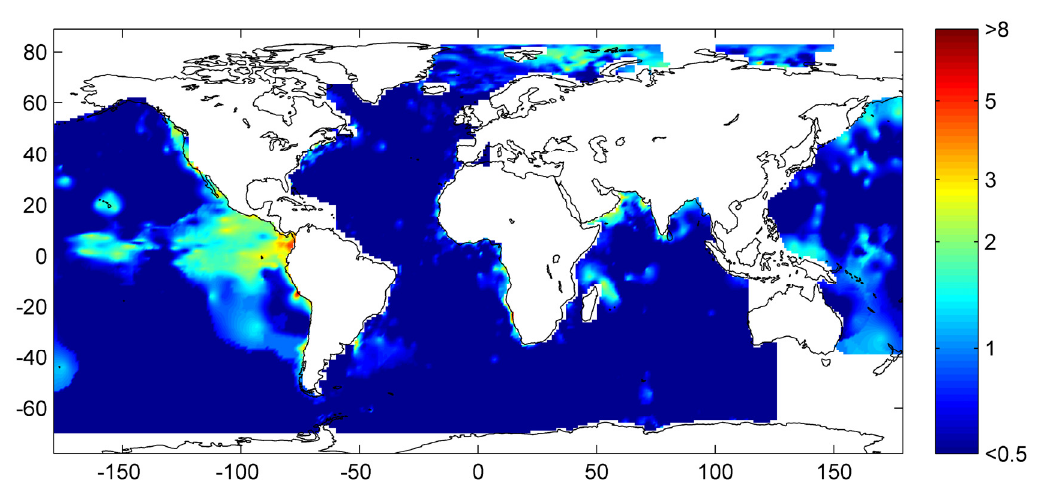
Figure 1. Concentration of particulate organic carbon (POC) in Holocene surface sediments [7,8]. The color coding indicates POC values in wt.%. Regions of the seafloor where data are not available are shown in